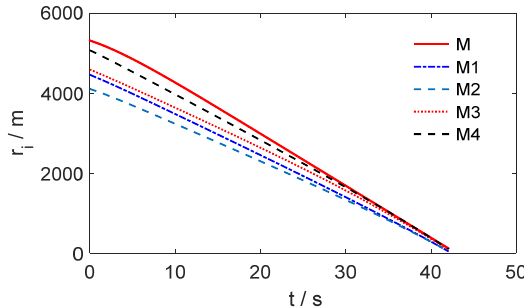
Figure 15. Tracking of the missile-target distance.